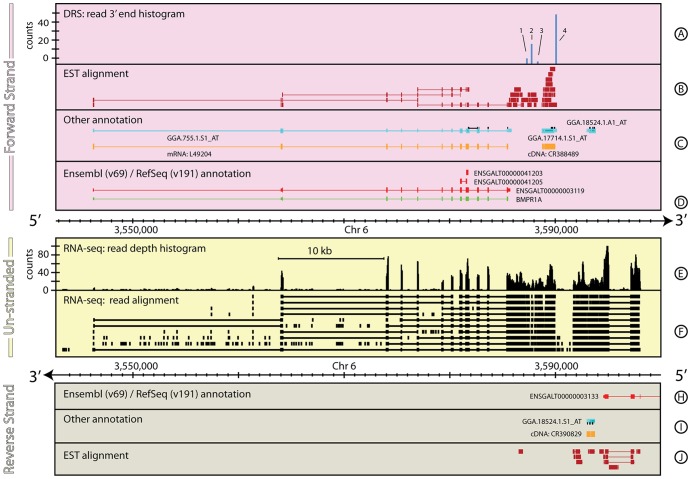
The genomic context around BMPR1A in G. gallus.
Figures 1–8 are divided into three regions comprising information located on the forward strand (pink), reverse strand (grey) and un-stranded information (yellow). Each region is subdivided into tracks showing a selection of the different annotations/datasets described below. For clarity, tracks are omitted where the track contains no data in the region shown. Tracks A & K: Histograms for forward (A) and reverse (K) strands computed by summing the number of uniquely aligned DRS reads that end at a position and presented in units of read-counts/base. Tracks B & J: Filled rectangles show forward (B) and reverse (J) strand individual EST alignments for a selection of the total EST coverage. Individual EST alignments that span across an implied exon splice junction are illustrated by a split bar representing the sequenced EST joined by a thin line that spans the implied intron. Tracks C & I: Additional annotation information for forward (C) and reverse (I) strands. This track shows annotation information that doesn't originate from a primary reference database for the species. Details of the specific annotations shown for each figure are given in the figure caption. Tracks D & H: Primary database annotations labelled with the database primary identifier for forward (D) and reverse (H) strands. Multiple gene models are shown where appropriate. Exons are shown as thick bars, UTRs as thinner bars and introns as thin lines. For A. thaliana this track shows the TAIR (v10) annotations. For the other examples in this paper, this track shows Ensembl (v69, red) and RefSeq (v191, green) annotations. Track E: Unstranded RNA-seq read depth histogram, computed by summing the number of uniquely aligned reads that cover at any given position and expressed in read counts/base. Track F: RNA-seq individual read alignments, for a selection of the total read depth, shown as filled rectangles. Individual read alignments that span across an implied exon splice junction are represented by a split bar representing the sequenced read joined by a thin line showing the implied intron. Track G: Unstranded sRNA-seq read depth histogram, computed by summing the number of uniquely aligned sRNA-seq reads that cover at any given position and expressed in units of read-counts/base. Figure 1 shows a ∼57 kb region of G. gallus, chromosome 6, including BMPR1A (ENSGALT00000003119) and illustrates a straight-forward gene re-annotation, where the RNA-Seq and DRS data combined are sufficient to define the extent, structure, and alternative polyadenylation positions for a gene. Tracks C & I show confirmed complete coding sequence mRNA data for the region (GenBank v191 - orange) and the locations of the Affymetrix chicken GeneChip microarray probe-sets (black markers), and the cDNA against which the Affymetrix probe-sets were designed (light blue). See the Materials and Methods section for more details on the generation and processing of the G. gallus RNA-seq and DRS data-sets. The EST data (B & J) are from [47]. The DRS track for the reverse strand (Track H) contains no data in the region shown and has been removed for clarity.